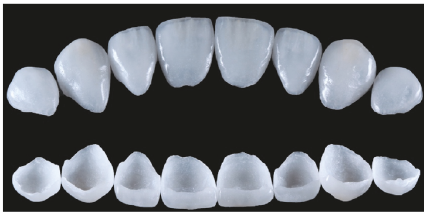
Figure 13: Finished ceramic veneers and vestibular and intaglio surface view.